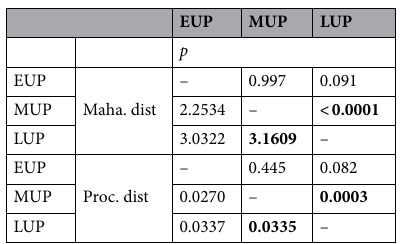
Table 2. Mahalanobis and Procrustes distances between the samples calculated from the aligned 3D coordinates and associated p-values from permutation tests (10,000 permutations rounds).